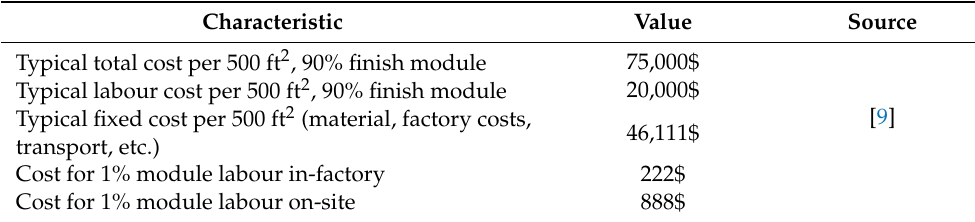
Table 3. Hypothesis for economic scenario and